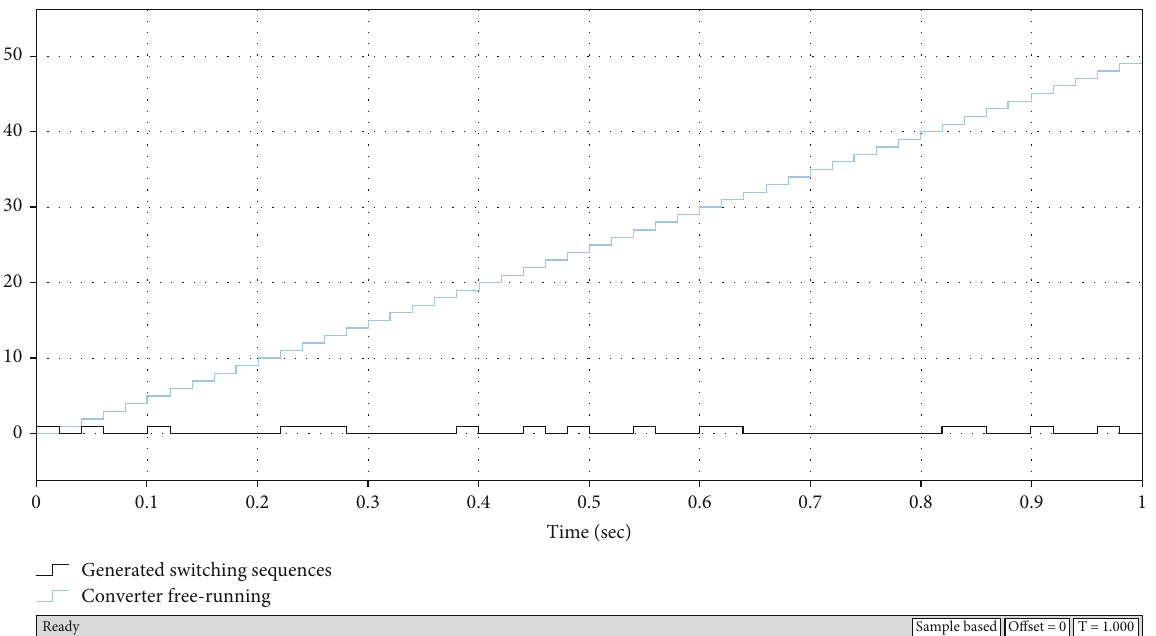
Figure 23: Pulse counter and generated switching sequences for the K